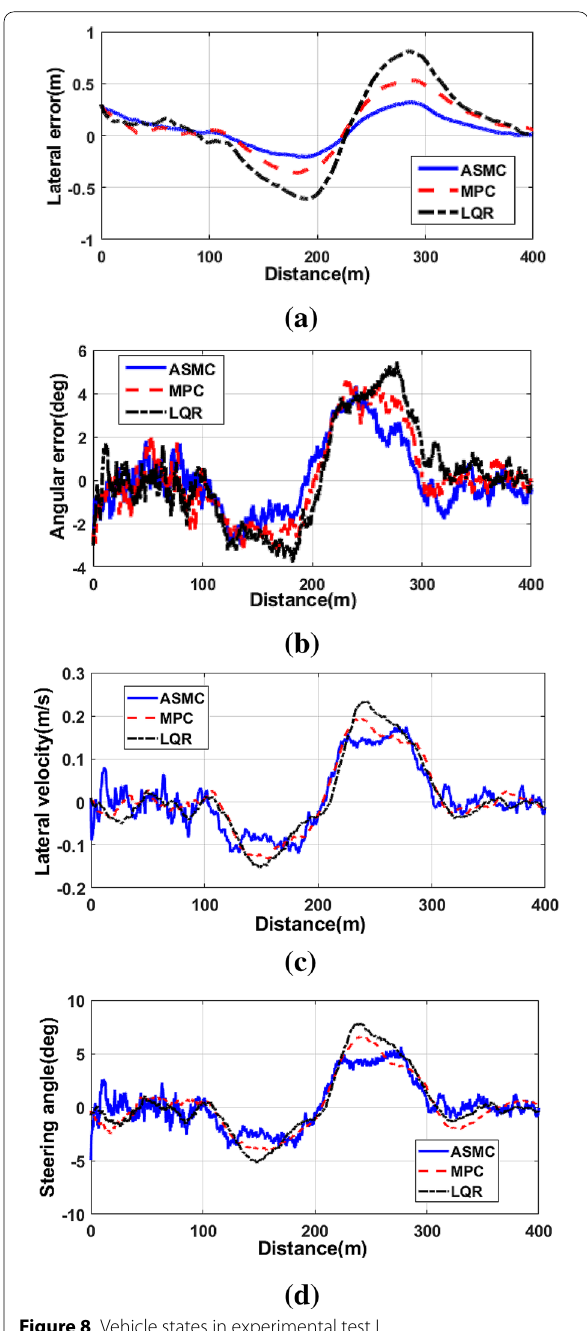
Figure 8 Vehicle states in experimental test I